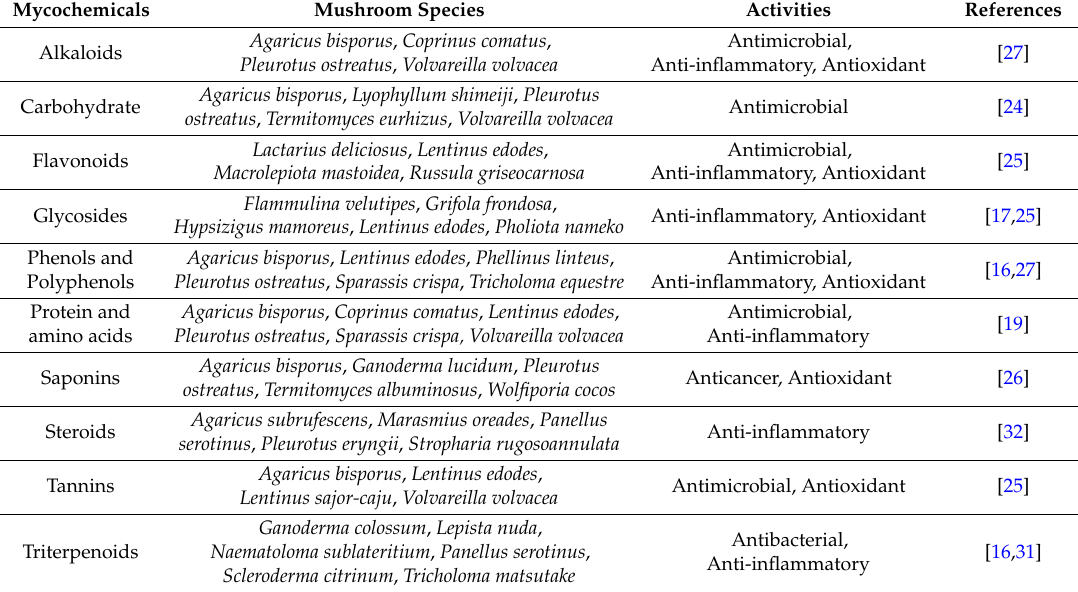
Table 1. Mycochemical analysis and activities from various